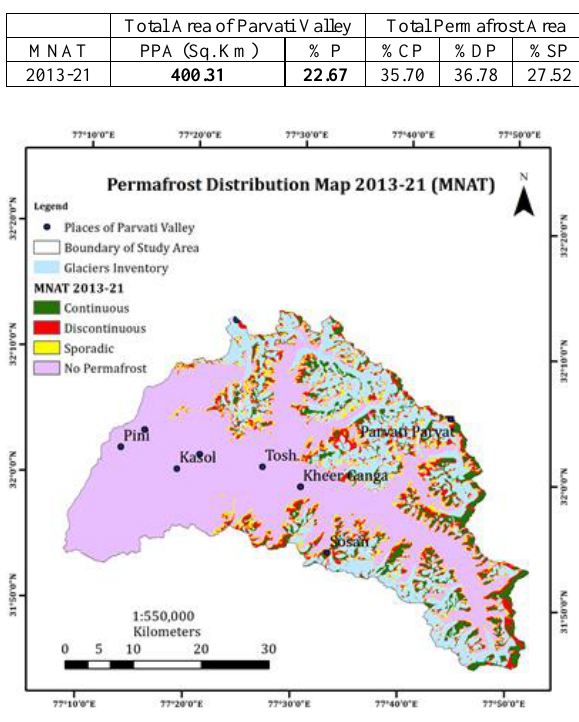
Table 8: The table summarizing the total probable permafrost area (in Sq. Km and %) and the percentage of permafrost area in different categories (CP, DP, SP) using MNAT for each consecutive years starting from 2013 to 2021.